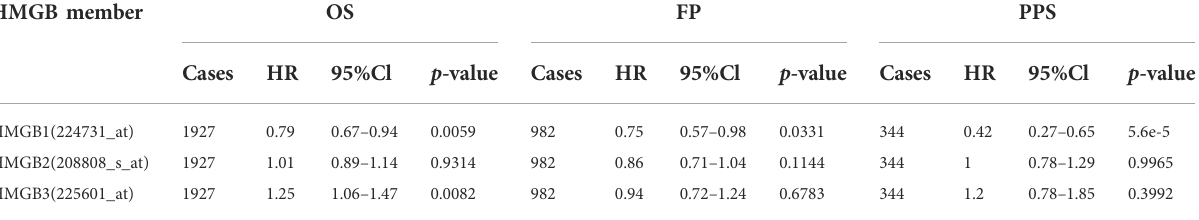
TABLE 3 The prognostic values of HMGB family members in lung cancer patients (Kaplan – Meier plotter). HMGB member OS FP